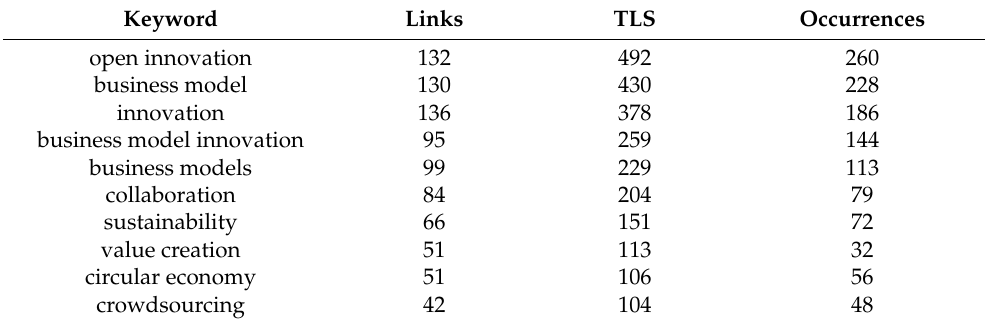
Table A1. Structural bibliometric indicators for the top ten authors’ keywords (ranked by